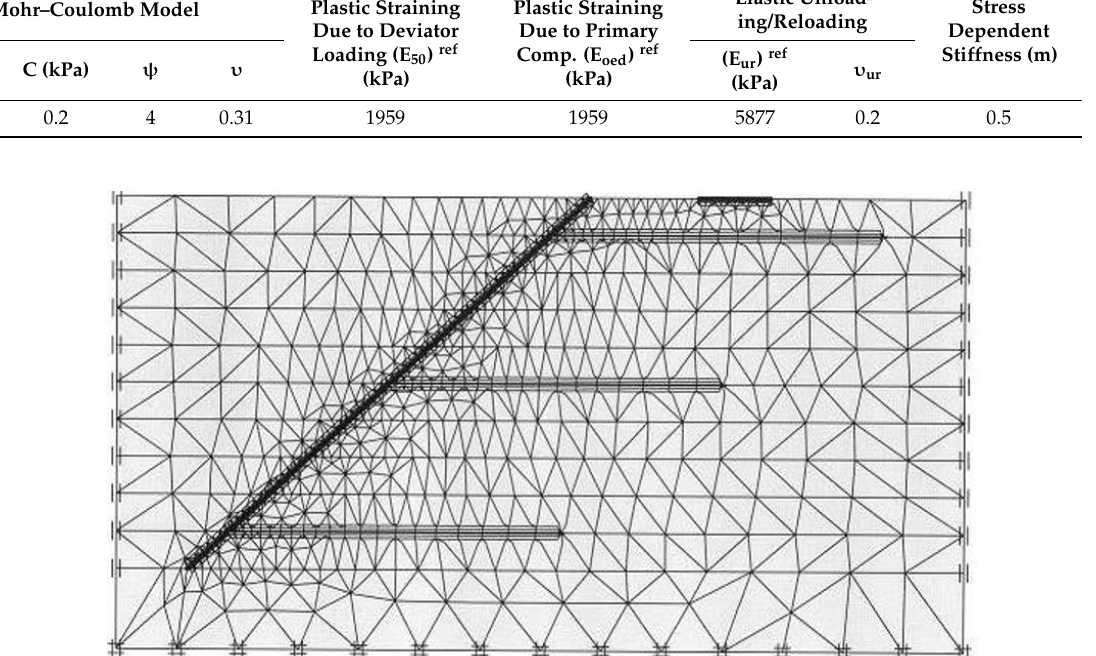
Figure 29. Discretized model of slope.